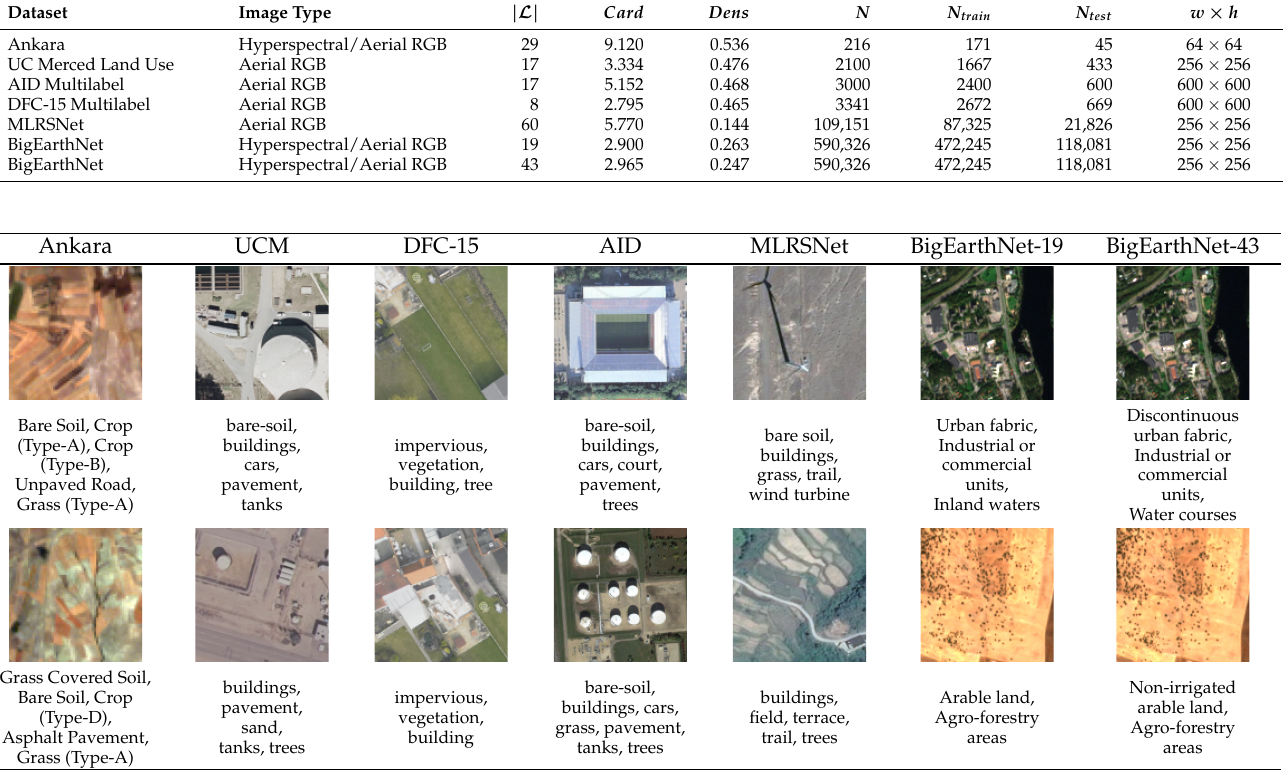
Figure 1. An illustration of the diversity of images from the different RSI datasets with the corre- sponding class